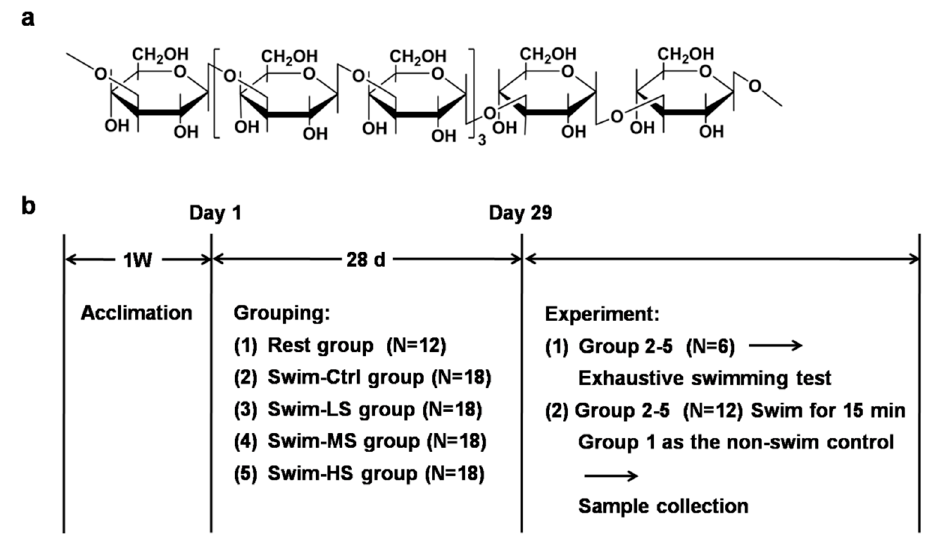
Figure 1. Chemical structure of the repeated unit of Salecan ( a ) and the experiment scheme ( b ). Rest group: mice that received phosphate buffer saline (PBS) intragastrically and did not take the swimming test; Swim-Ctrl, Swim-LS, Swim-MS, and Swim-HS groups: mice that received 0, 25, 50, and 100 mg/kg of Salecan intragastrically respectively for four weeks before taking a 15-min swimming test.